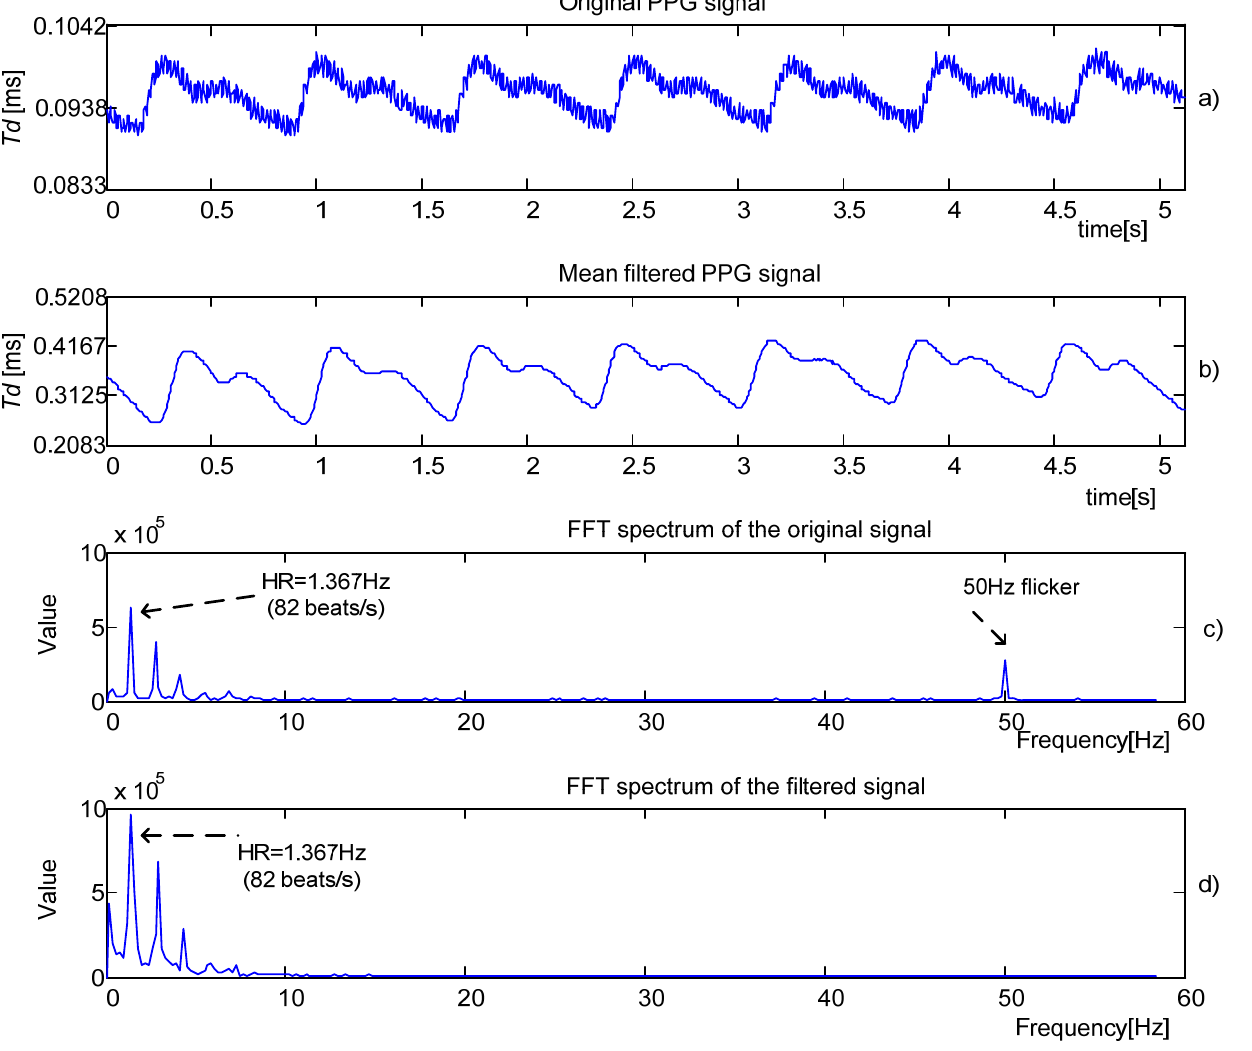
Figure 8. Experimental PPG signal ( a ) and signals obtained after processing by 16th order Mean filter ( b ) and FFT, ( c ) and ( d ), f